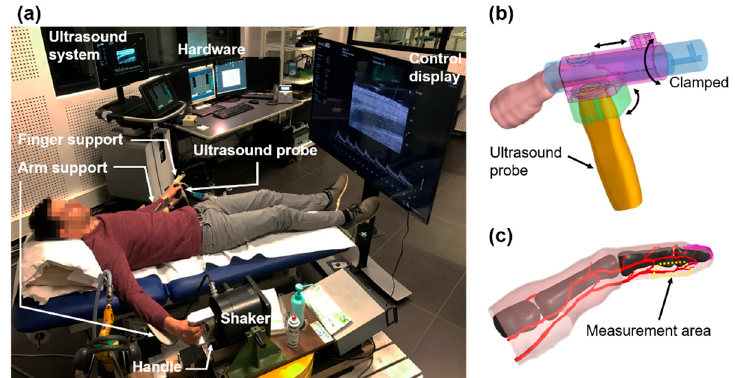
Figure 5. Experimental setup: ( a ) overall view; ( b ) positioning support of the ultrasound probe; ( c ) measurement area corresponding to the proper volar digital artery of the left index finger.